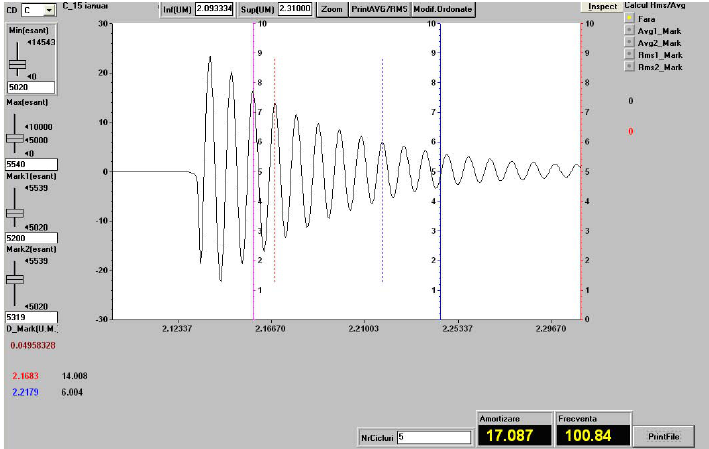
Figure 16. The vibration recording (the characteristic frequency and the damping factor) for a composite sample of the hemp fabric set, for the free length of 120